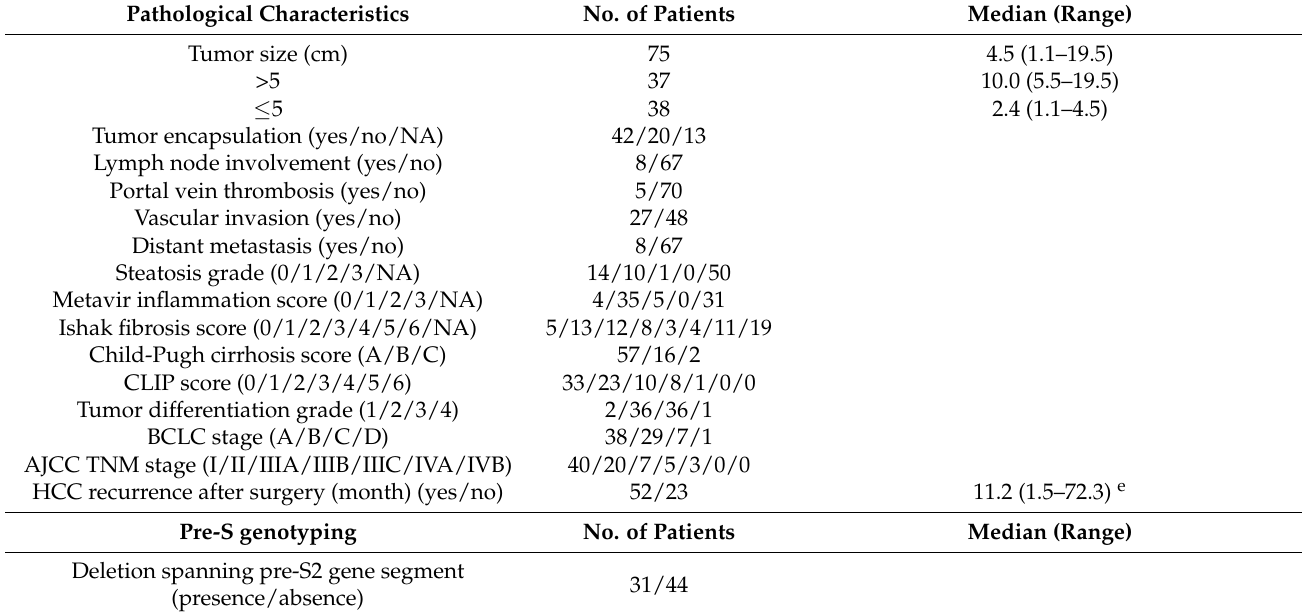
3.2. Association of Low Serum Albumin Level with Pre-S2 Mutant-Positive HCC Patients